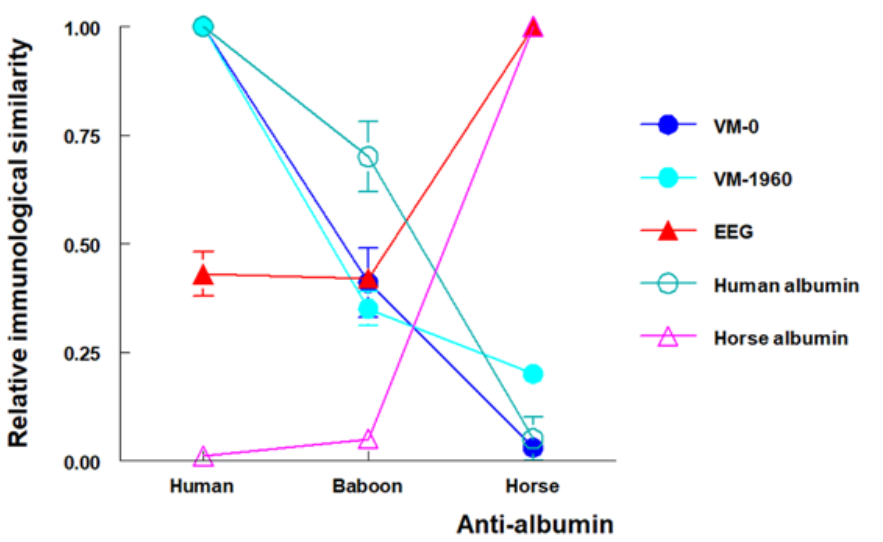
Figure 2. Reactivity of EDTA extracts of fossils from the Venta Micena site with three polyspecific mouse sera against human, baboon, and horse albumin in an enzyme-linked immunosorbent assay. VM-0 (skull fragment) and VM-1960 (humeral diaphysis) were assigned to hominins; EEG is a skull fragment of an equid fossil. All three specimens were dated to 1.3 million years old. The results are expressed as relative immunological similarity, defined as the ratio of each reaction to the homolo- gous (most specific) albumin determination. VM-0 and VM-1960 produced a pattern of reactions